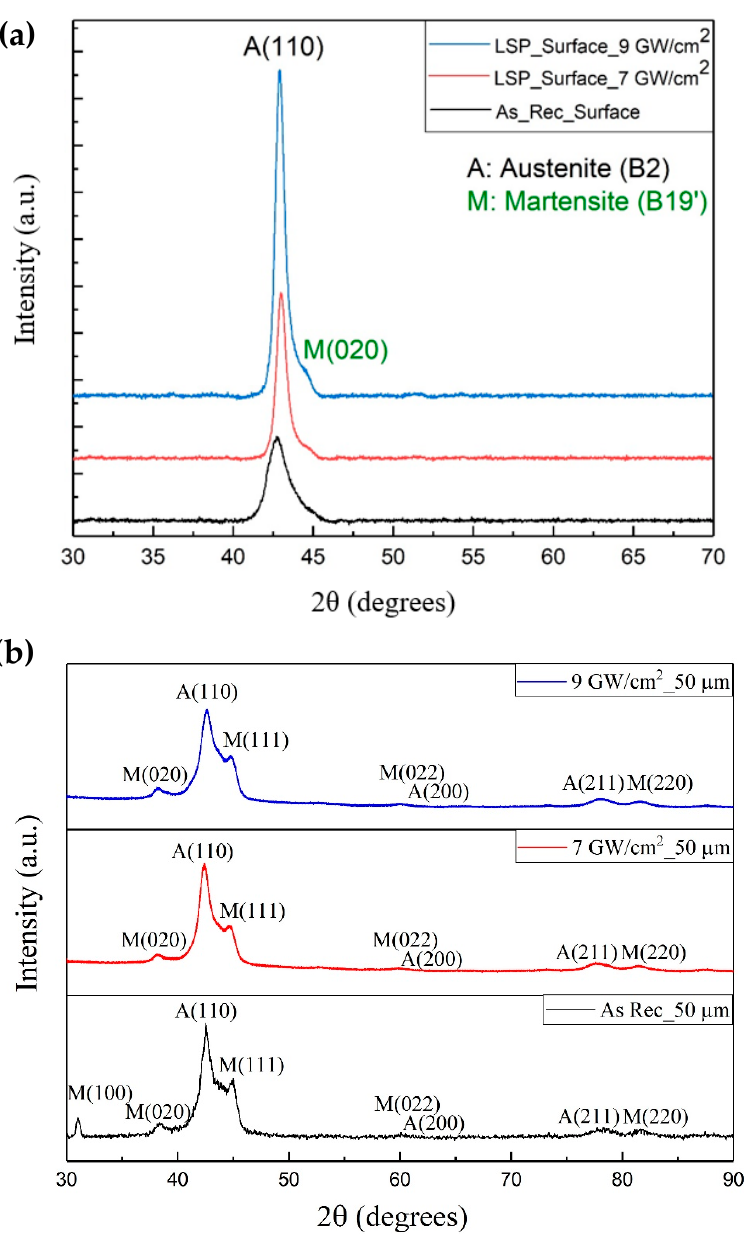
Figure 3. ( a ) XRD patterns of the as-received Nitinol and samples laser shock peened at 7 and 9 GW/cm 2 taken from the surface region. ( b ) XRD patterns of the as-received Nitinol and samples laser shock peened at 7 and 9 GW/cm 2 taken at a depth of 50 µ